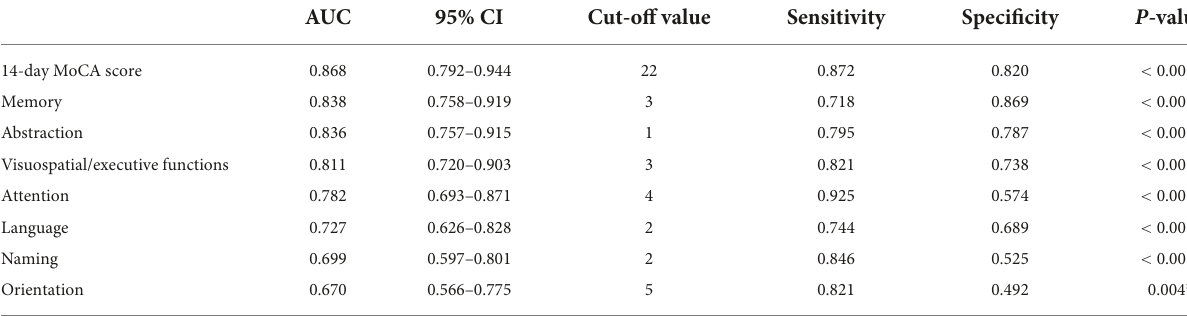
TABLE 5 Receiver operating characteristic analysis of